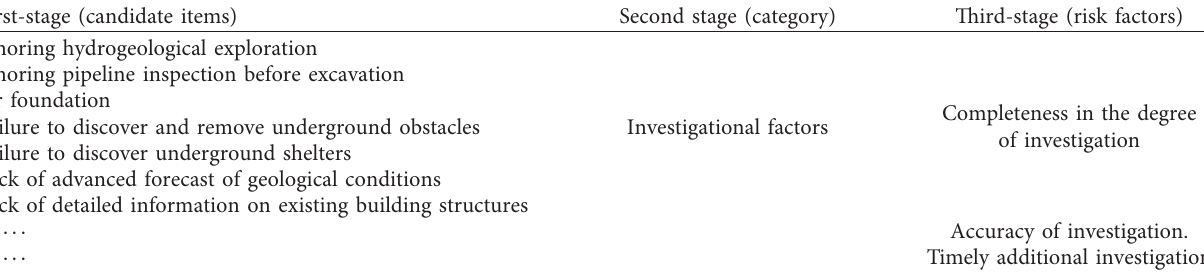
Table 2: Three-stage procedure for identifying investigation factors.